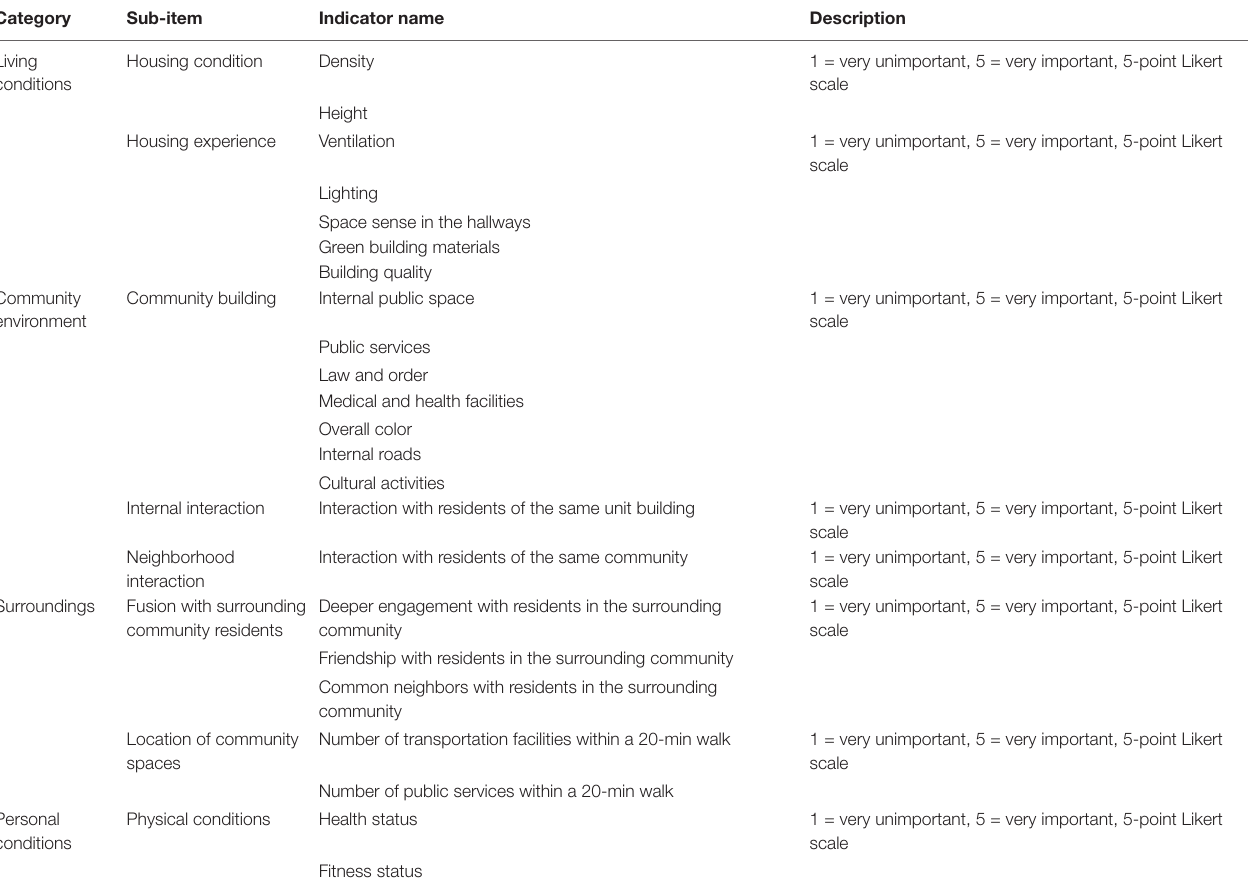
TABLE 2 | List of factors influencing the mental vulnerability of community residents.